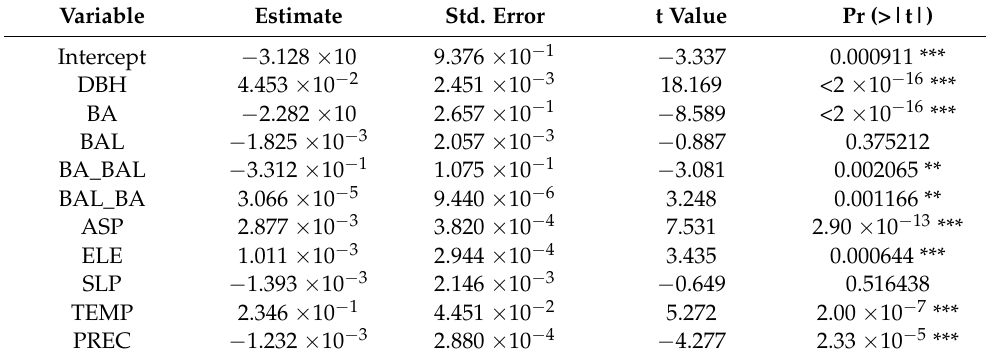
Table 9. Results of regression model analysis for diameter growth of trees under change climate.